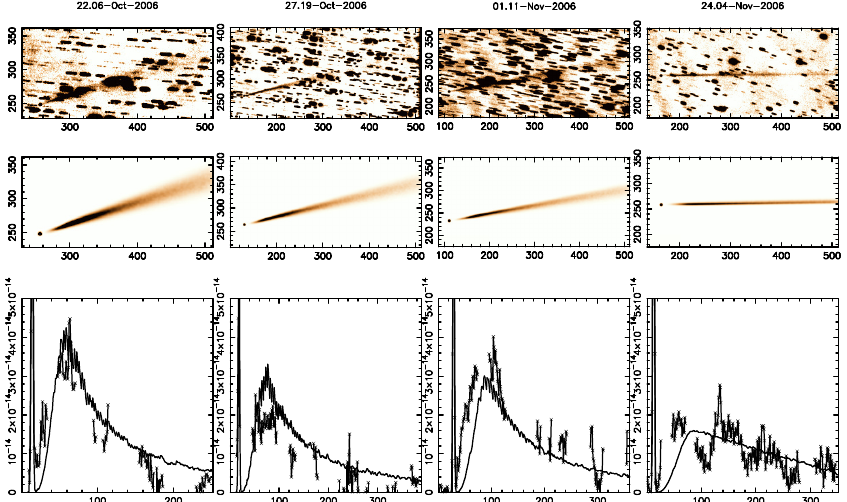
Figure 7. Upper panels: observations of comet 249P/LINEAR with the 0.4 m telescope of Great Shefford Observatory near 2006 perihelion at four epochs. Middle panels: best-fit synthetic images obtained with the same dust physical parameters obtained as for the 2016 images in Figure 6 except for a somewhat smaller production rate. The nucleus is seen detached from the tail in the observations and the simulations. The physical dimensions of the images are in km × km and from left to right, 176,734 × 83,683, 266,040 × 126,224, 131,879 × 133,907, and 350,470 × 164,982. Lower panels: scans along the tail for the observed (crosses joined by straight lines) and model (solid lines). The observed scans drawn are limited to the less contaminated regions by background trailed stars. The x- and y- axis of the scans are expressed in pixel and solar disk intensity units, respectively. Adapted from